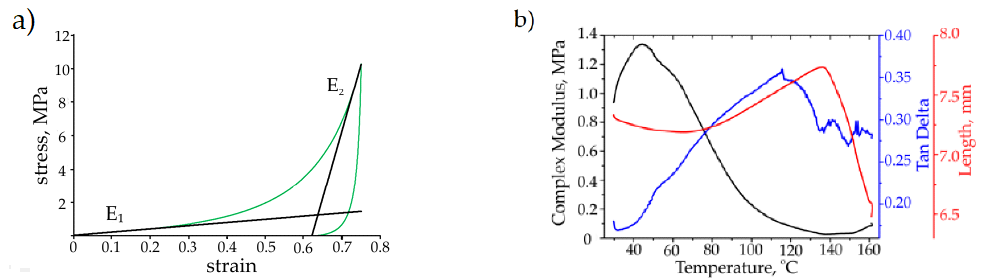
Figure 5. The static ( a ) and dynamic ( b ) mechanical properties of porous open-cell UHMWPE (fabricated from 75 to 150 µm powder fraction). Table 1. The static and dynamic mechanical properties of porous open-cell UHMWPE.